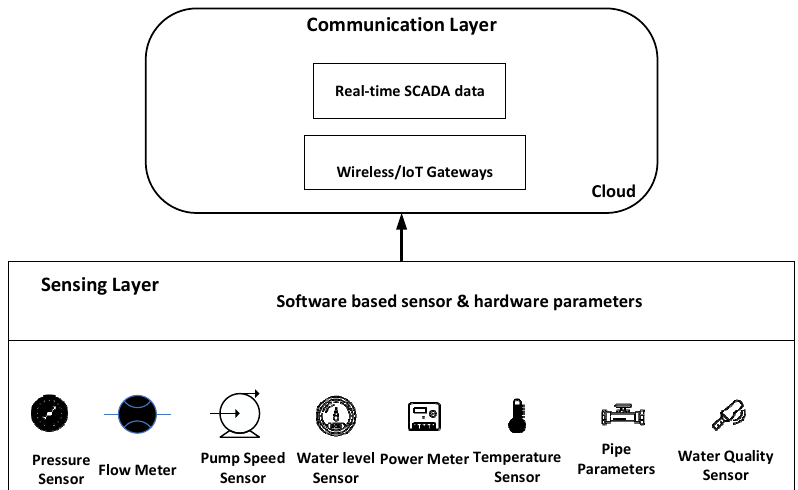
Figure 2. Communication and Sensing Layers.